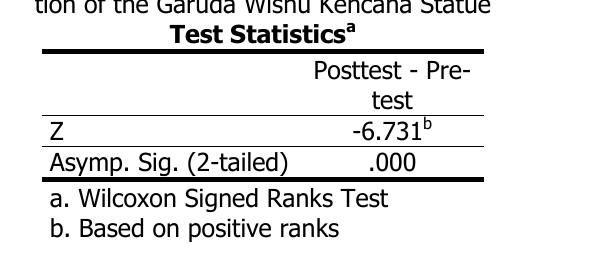
Table 15. Statistical Test of the Influence of Visitation Motivation Variables after The